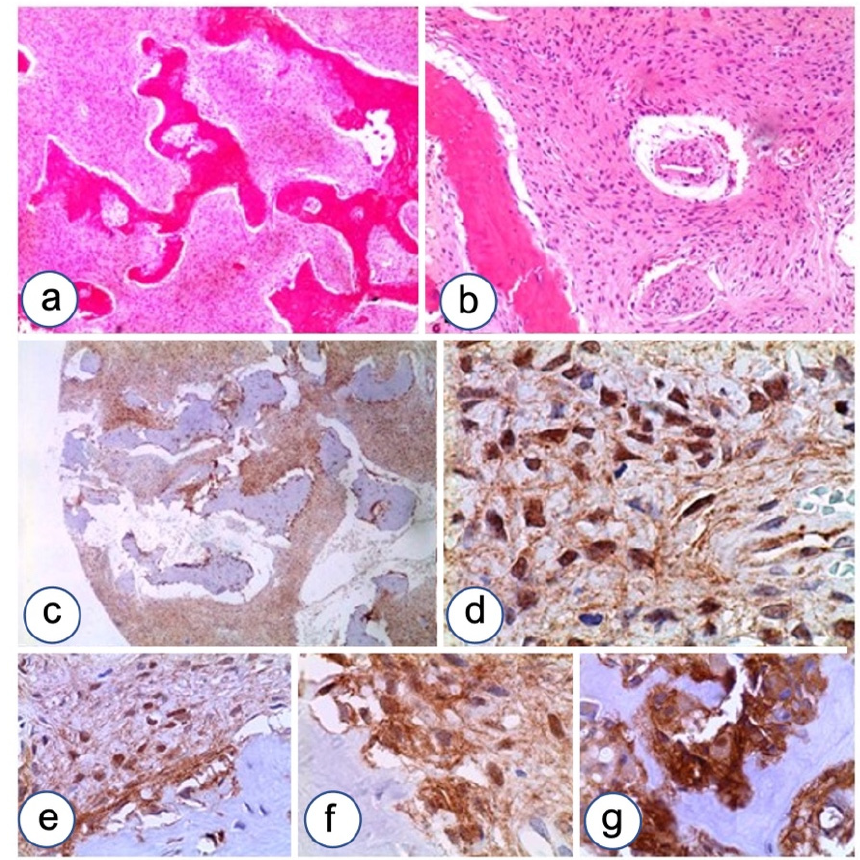
Figure 3. B-catenin over-expression in FD. ( a , b ) A representative case of FD with Chinese ideogram pattern (hematoxylin and eosin) showing strong immunostaining for β -catenin ( c ), with cytoplasmic- nuclear delocalization ( d ), especially localized in the area surrounding dysplastic bone trabeculae lined by retracted osteoblasts ( e – g ); LSAB-HRP, nuclear counterstaining with Gill’s type II hematoxylin. Magnifications, ×4 (a,c), ×10 (b,e), ×20 (f,g), ×40 (d).